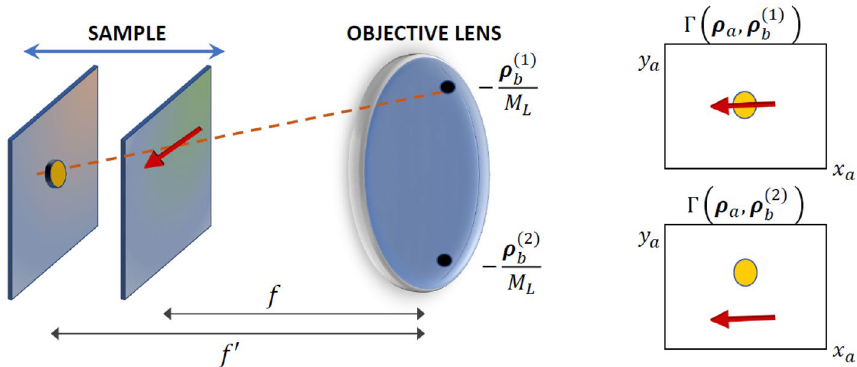
Figure 2. Schematic representation of the different points of view on the 3D sample that the correlation function Ŵ( ρ a , ρ b ) incorporate (Eq. (2)); here, ρ i = ( x i , y i ) , i = a , b . A thick sample is represented through a ′ (yellow) circle and a (red) arrow placed at distances f and f , respectively, from the objective lens. These two details can appear superposed (upper panel on the right) or well separated (lower panel on the right) depending on the specific transverse coordinate ρ b chosen on detector D b , that corresponds to a point − ρ b / M L on the objective